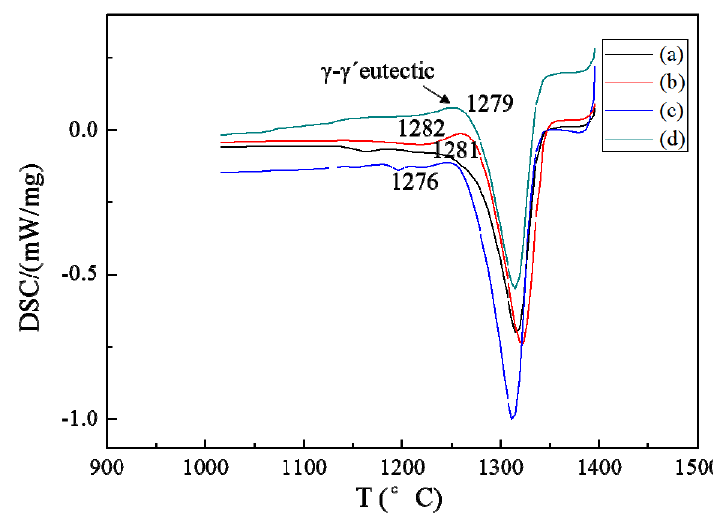
Figure 8. DSC heating curve (1000–1400 °C, 20 °C·min − 1 ) of directionally solidified superalloy at a temperature gradient of 80 K·cm − 1 , drawing speed of 10 μ m·s − 1 : ( a ) 0 T, diameter of 4 mm; ( b ) 0.5 T, diameter of 4 mm; ( c ) 0 T, diameter of 12 mm; ( d ) 0.5